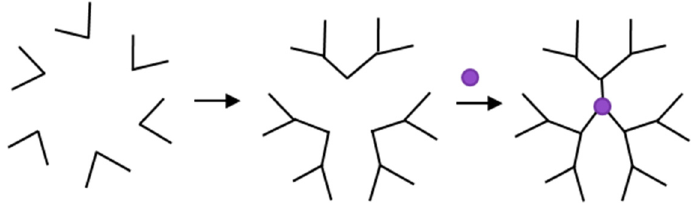
Figure 4. The convergent method of dendrimer synthesis.